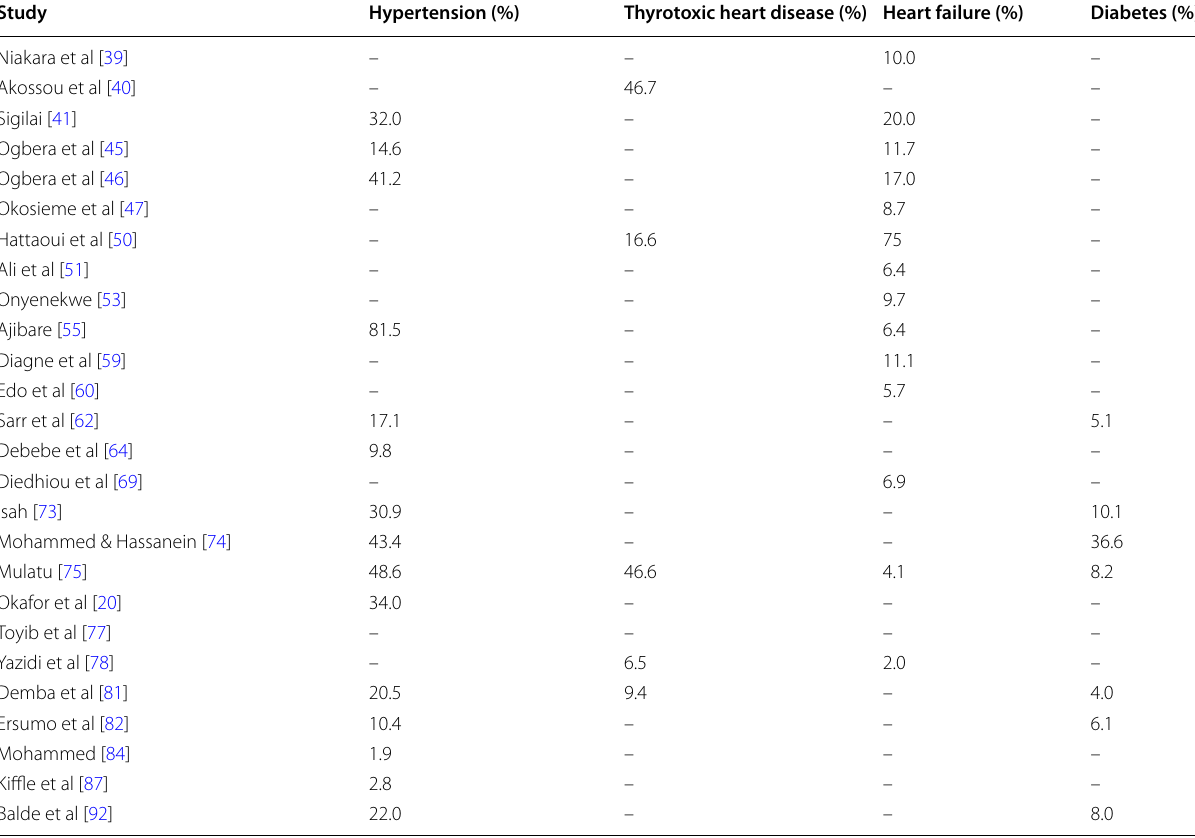
Table 10 Associated cardiometabolic morbidities